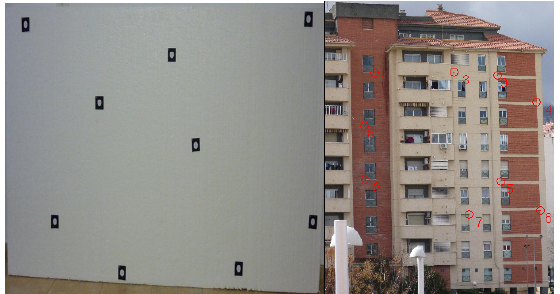
Figure 5. Left: targets for TDC test area. Right: building façade for EDIF